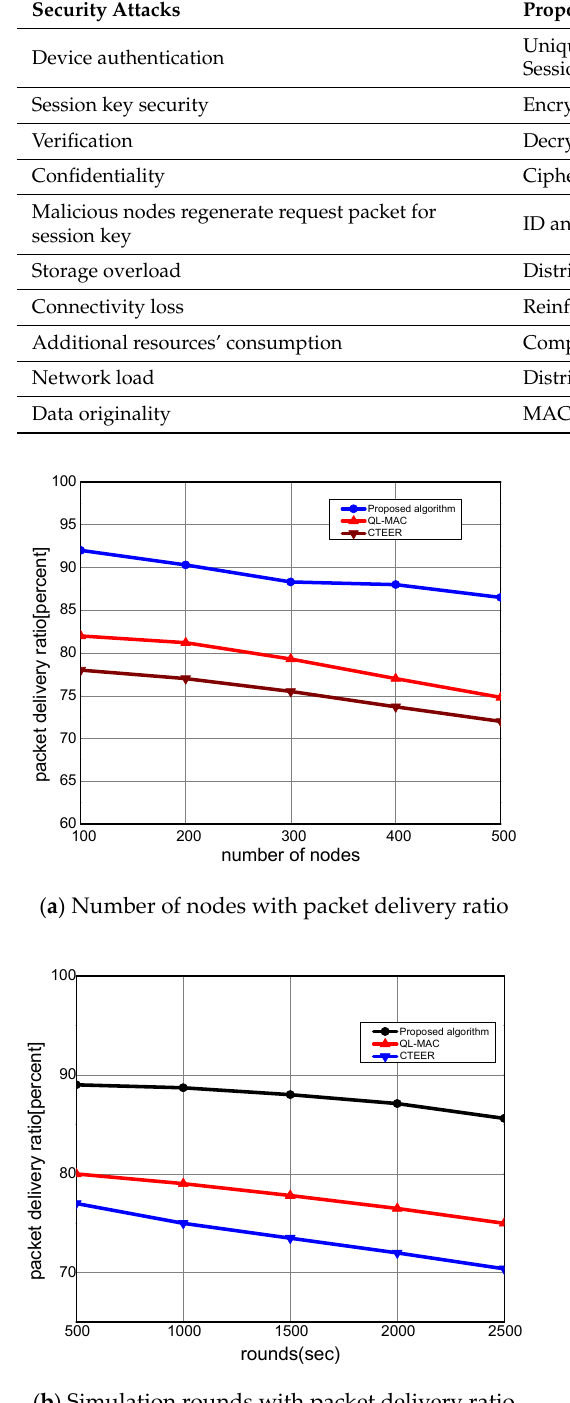
Figure 6. The performance evaluation of the proposed algorithm compared to QL-MAC and CTEER for packet delivery ratio.